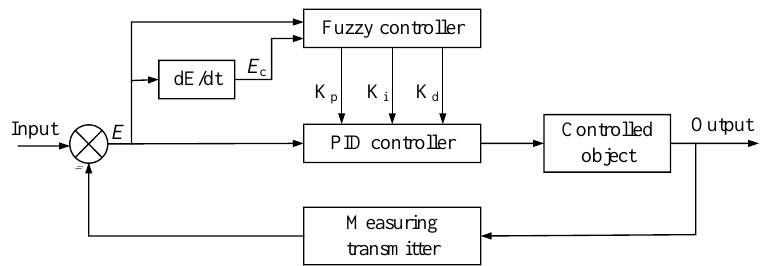
Figure 8. Structure of fuzzy adaptive PI controller.